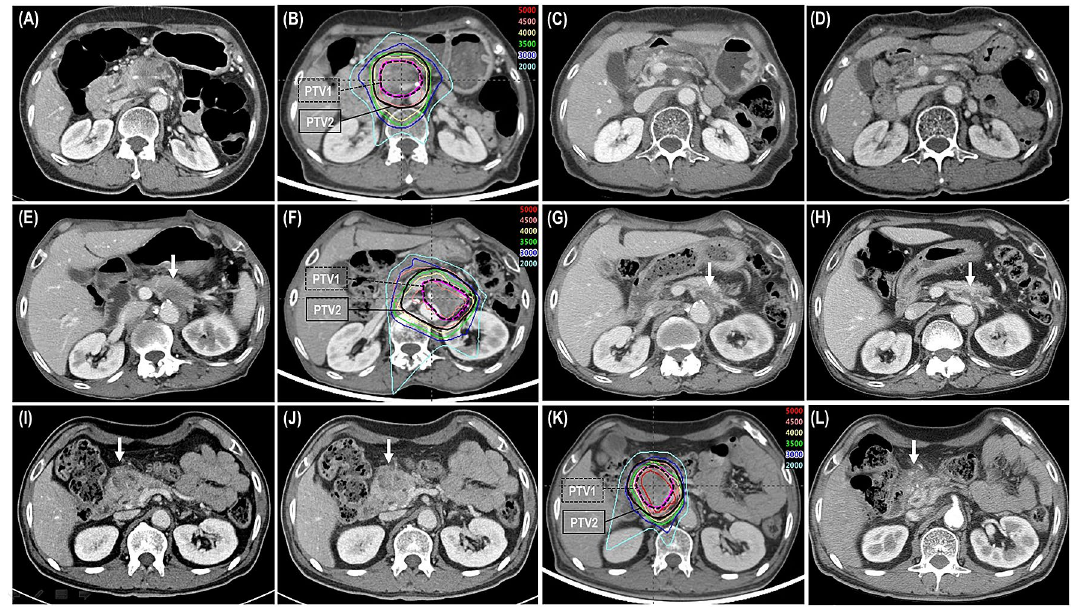
Figure 1. Partial response (PR) of a primary tumor after proton beam radiotherapy (PBT) in groups I ( A – D ), II ( E – H ), and III ( I – L ). In the group I: ( A ) initial CT scans showing the primary tumor (arrow); ( B ) the patient